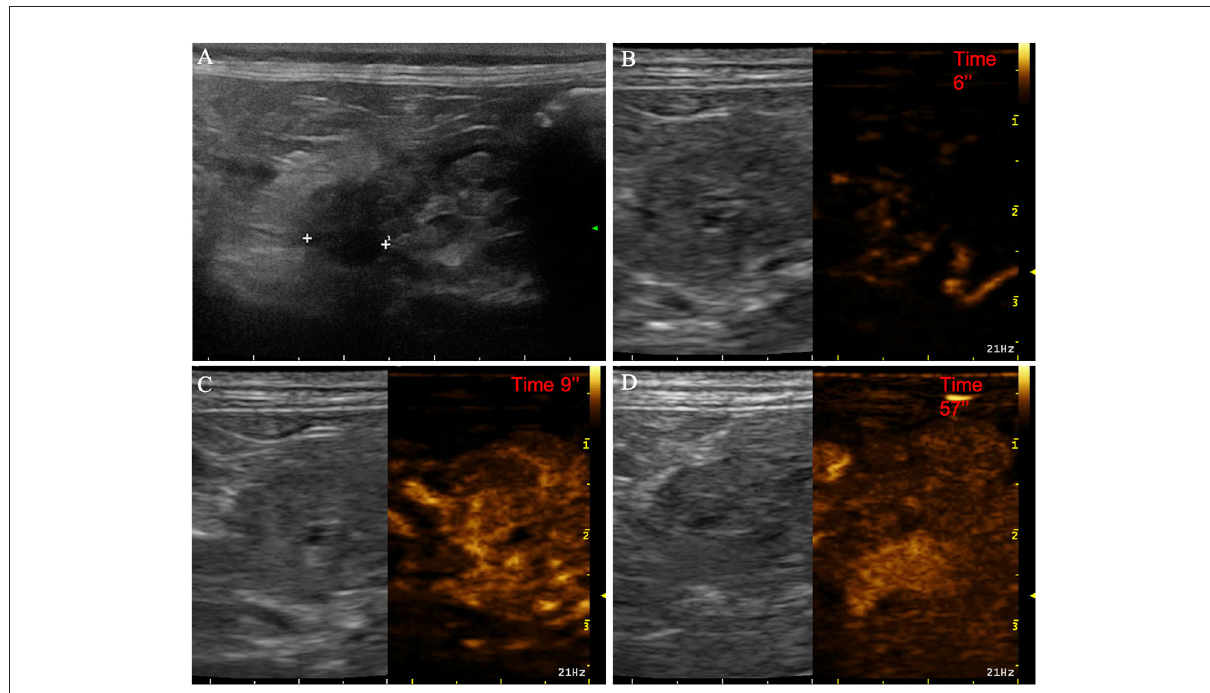
FIGURE3 Example of nodular hyperplasia showing: no pseudocystic appearance, hypoechogenicity, absence of acoustic enhancement, and presence of peripancreatic reactivity at US; isoenhancement, diffused and homogeneous distribution of contrast medium, absence of intralesional microcirculation and hypoperfused areas during wash-in at CEUS; no wash-out. (A) Image obtained from US examination; (B) image obtained at TTE; (C) image obtained at TTP; (D) image obtained during